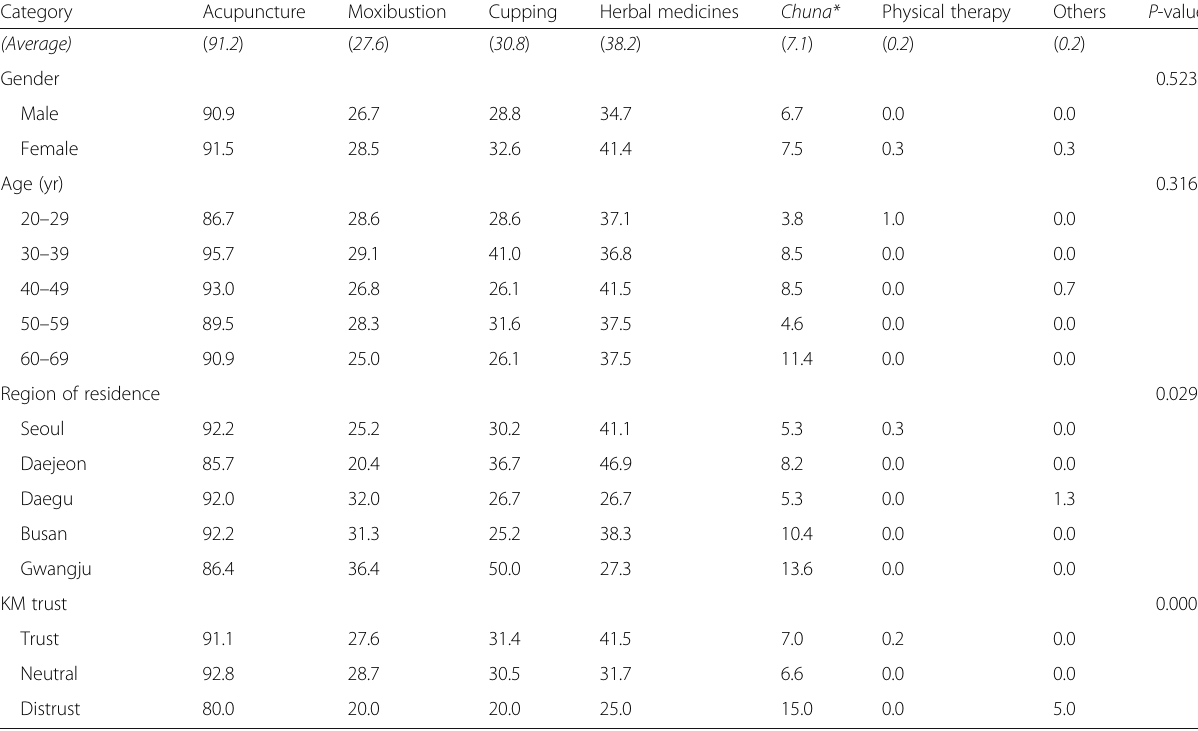
Averages are represented as ( n ). The 632 respondents who had experience with KM therapies were surveyed. These questions allowed for multiple answers. The values represent percentages of participants. * Chuna may involve chiropractic, Chuna , and other similar manual therapies primarily designed for back pain.